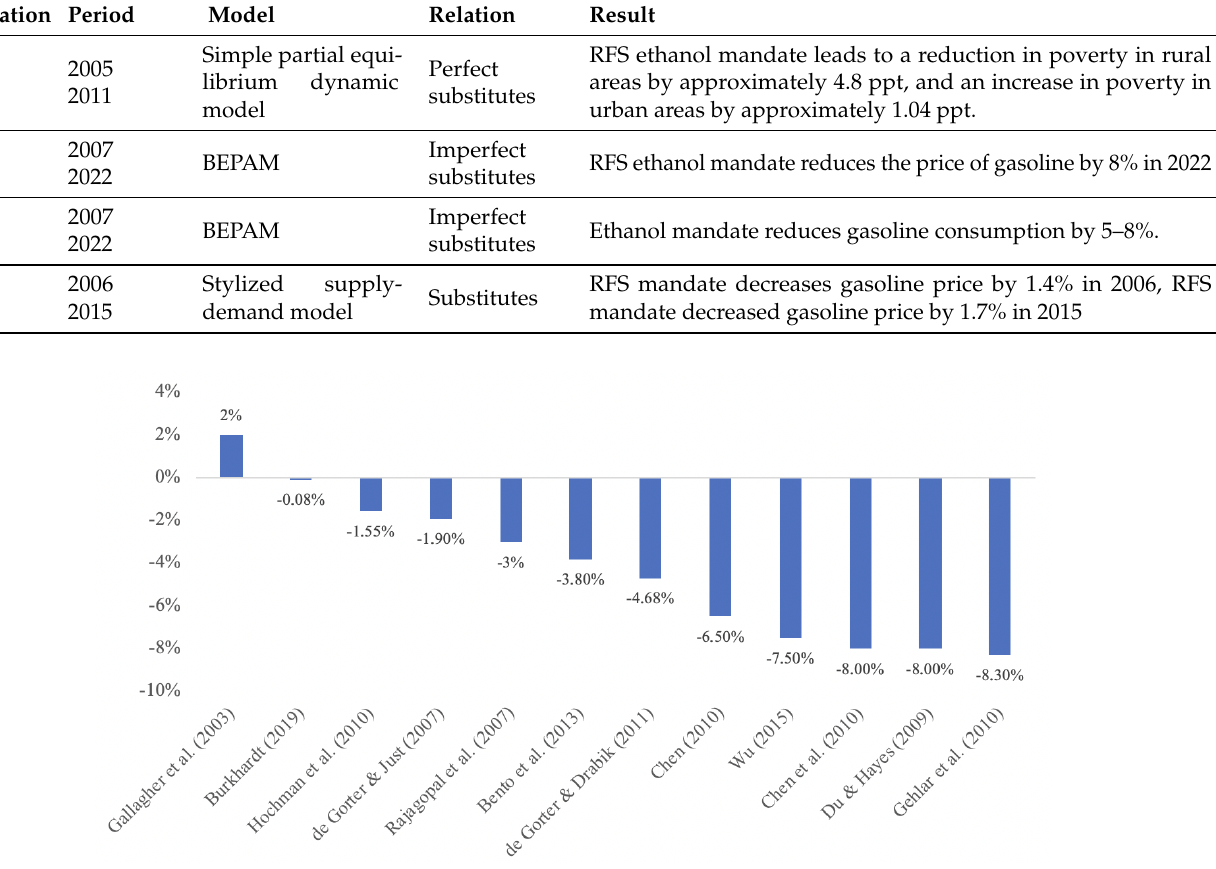
Figure 15. Ethanol’s relative effects reported in the